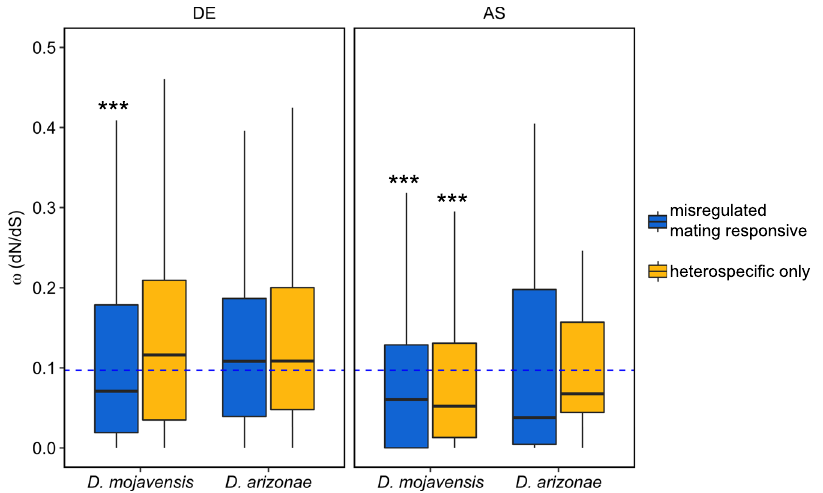
Fig. 9 Median pairwise ω (dN/dS) for genes that were misregulated in heterospeci fi c crosses. Blue boxes represent mating responsive genes in conspeci fi c crosses that were misregulated in heterospeci fi c crosses. Yellow boxes represent genes that were differentially expressed only in heterospeci fi c crosses. The median ω for the genome background (blue dash line) is indicated. Signi fi cant comparisons against the genome background using the Dunn method for joint ranking are indicated. P -values are noted: *** P < 0.001. Boxplots represent the median with 25th and 75th percentiles, and whiskers show the 1.5 interquartile